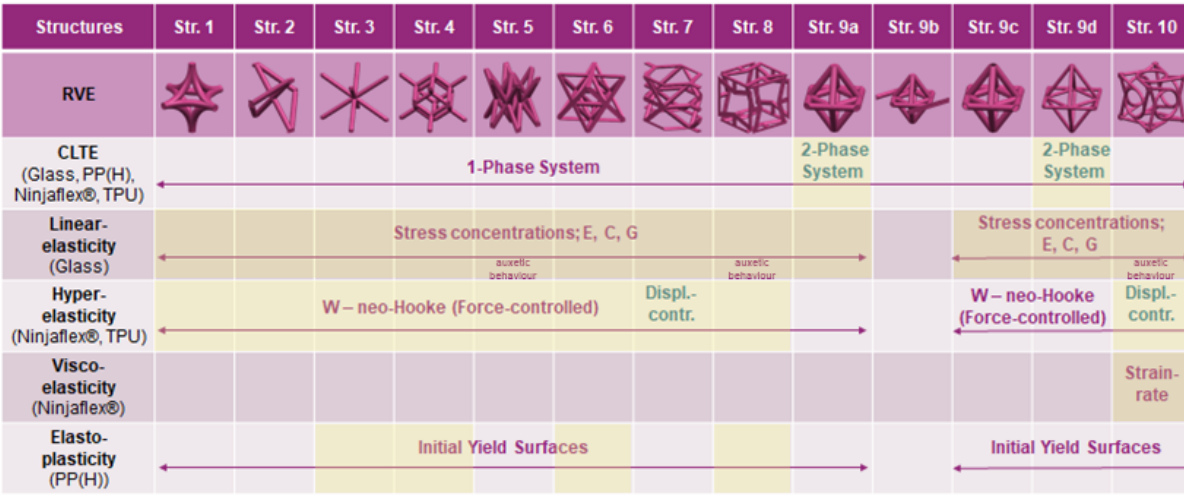
Figure 1. Task and procedure of the present work.